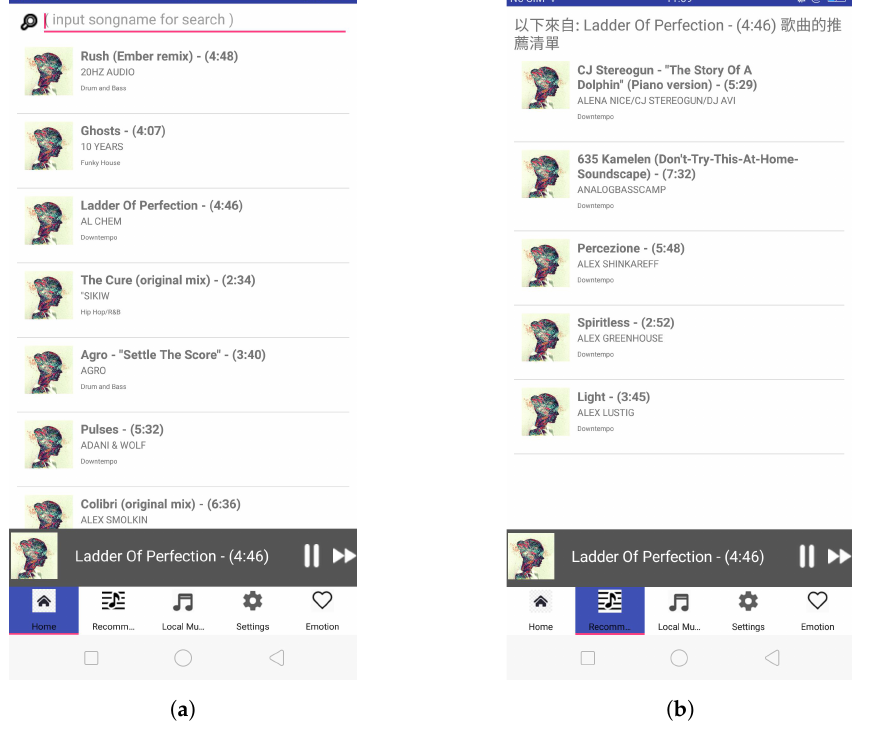
Figure 6. ( a ) music list available on the user’s device and the MusicAI’s server; ( b ) music recommendations’ list based on the user’s information and his current listening history of